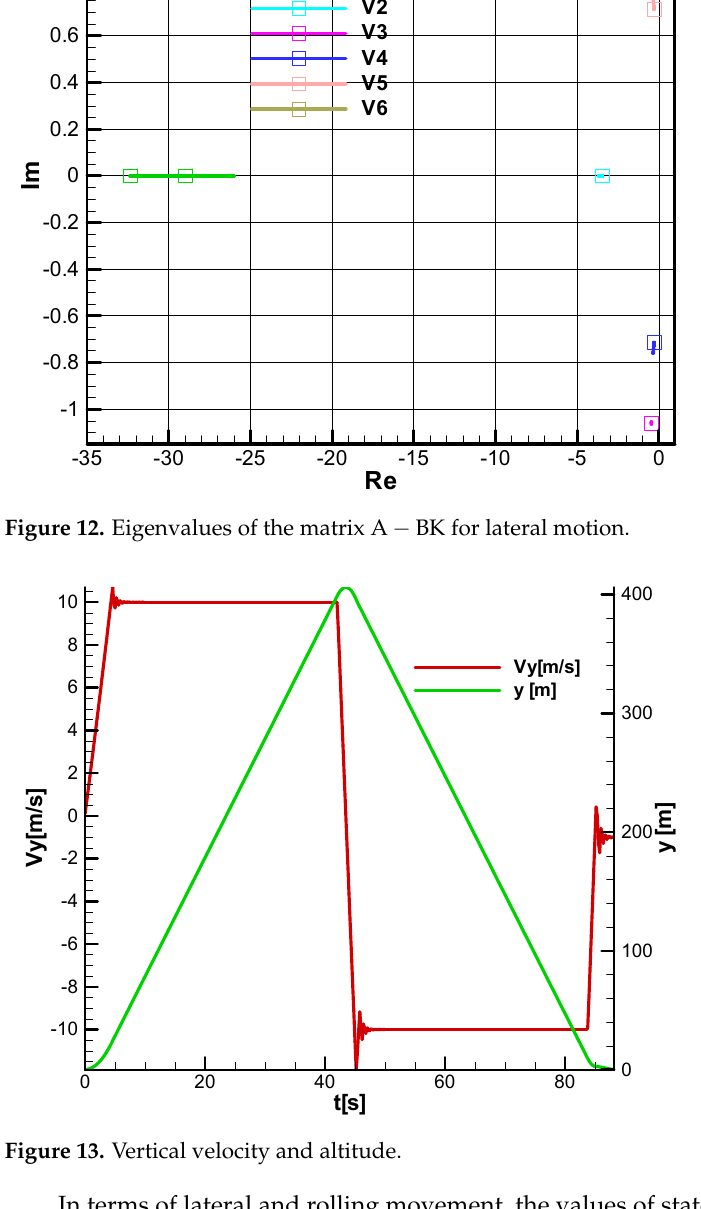
Figure 14. Diagram of the thrust throttling command dT . In terms of lateral and rolling movement, the values of states and commands are null during all flight phases. The lateral and roll channels have no state or command variations (their derivatives remain null) during the first flight scenario. (a)